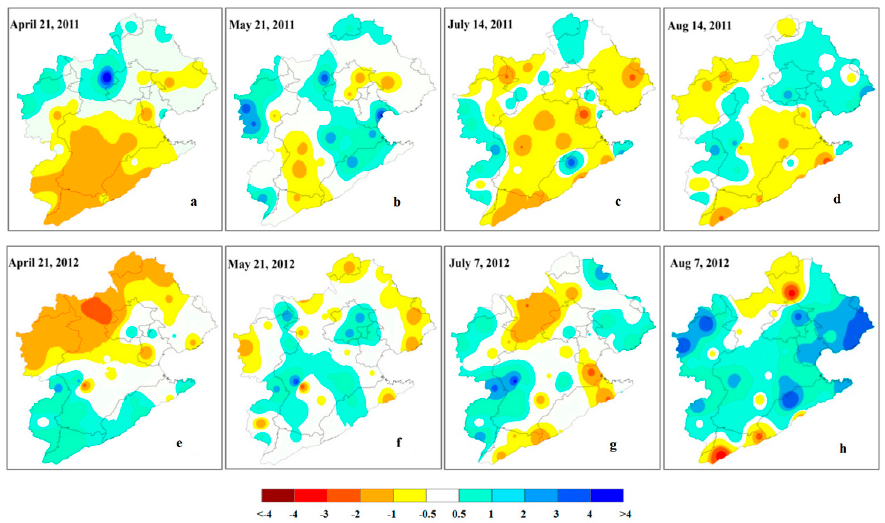
Figure 9. Spatial distribution of dry and wet based on the PDSI in the Haihe River Basin for ( a ) 21 April; ( b ) 21 May; ( c ) 14 July; and ( d ) 14 August 2011; and ( e ) 21 April; ( f ) 21 May; ( g ) 7 July; and ( h ) 7 August 2012.